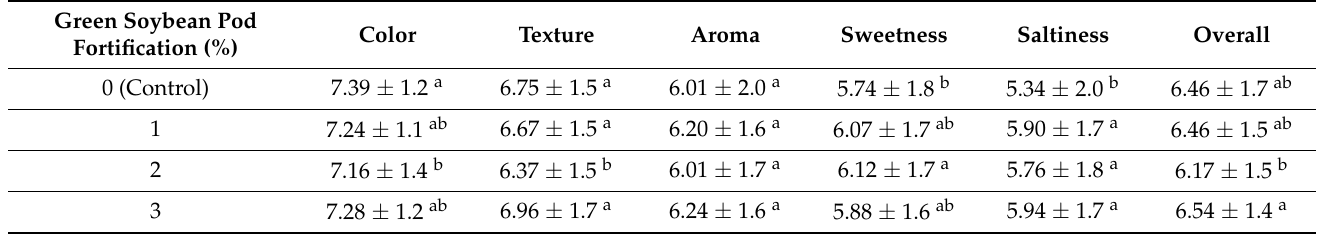
Table 4. Sensory analysis of green soybean milk fortified with GSP extracts. Product preference was evaluated using a 9-point hedonic scale.